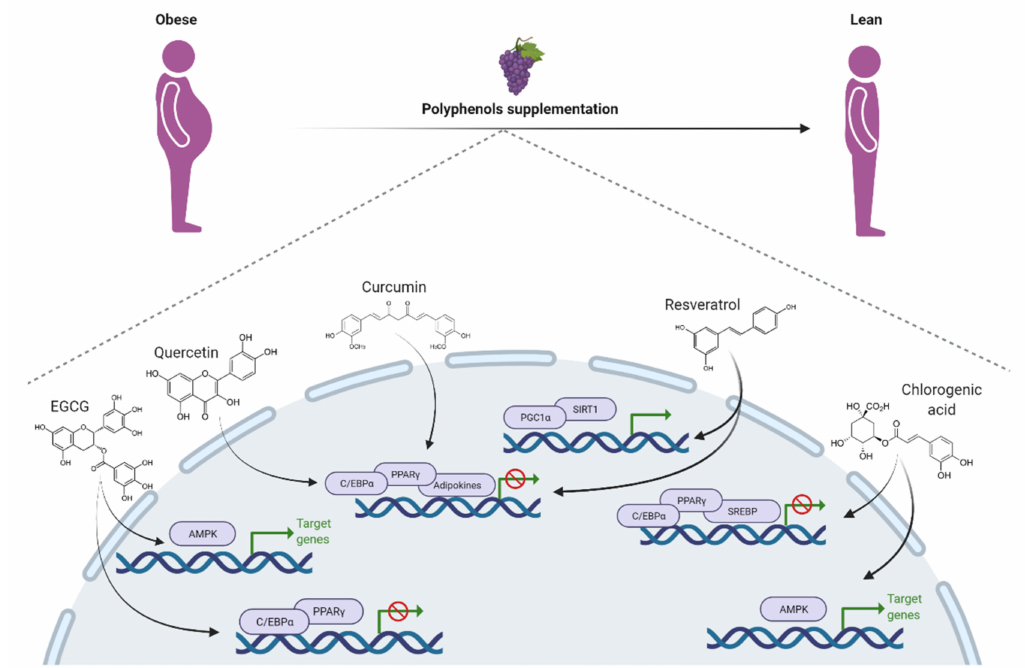
Figure 1. Schematic representation of molecular mechanisms underlying the anti-obesity effects of the main